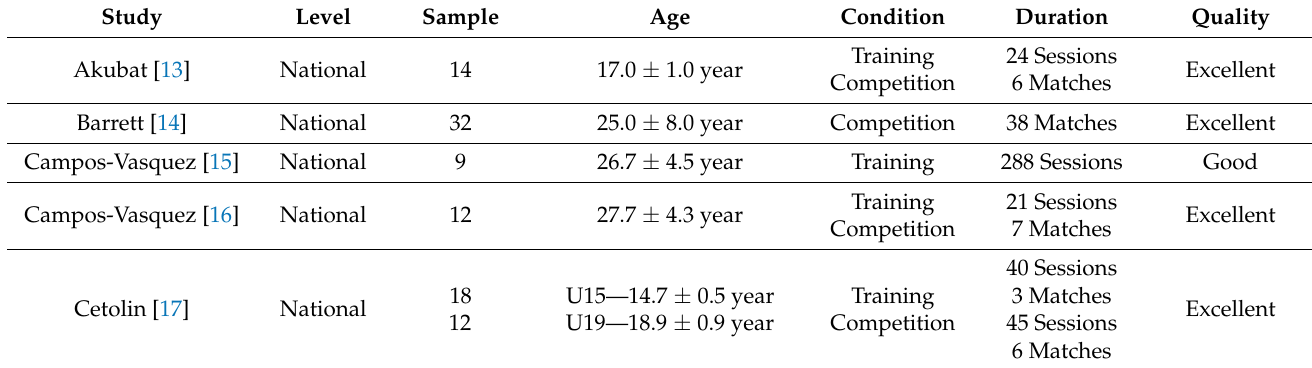
Table 1. Characteristics of studies that evaluated only internal load